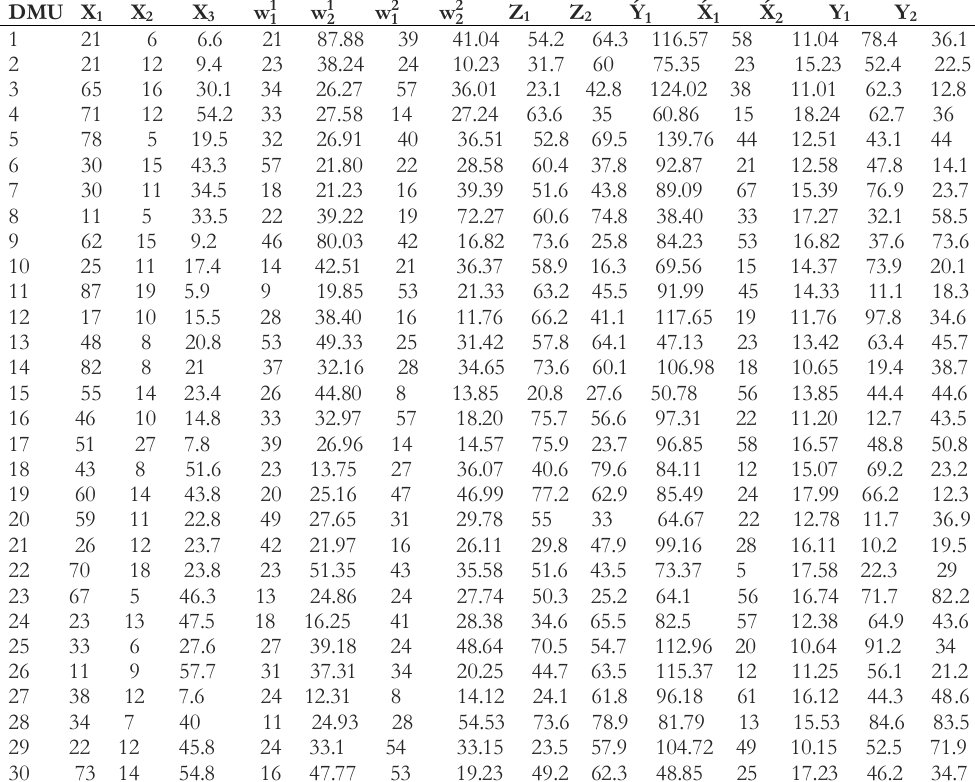
Table 3. Data in general two-stage network with flexible measure.